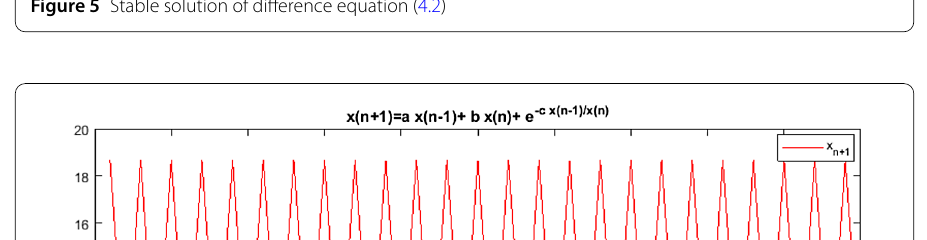
Figure 5 Stable solution of difference equation (4.2)